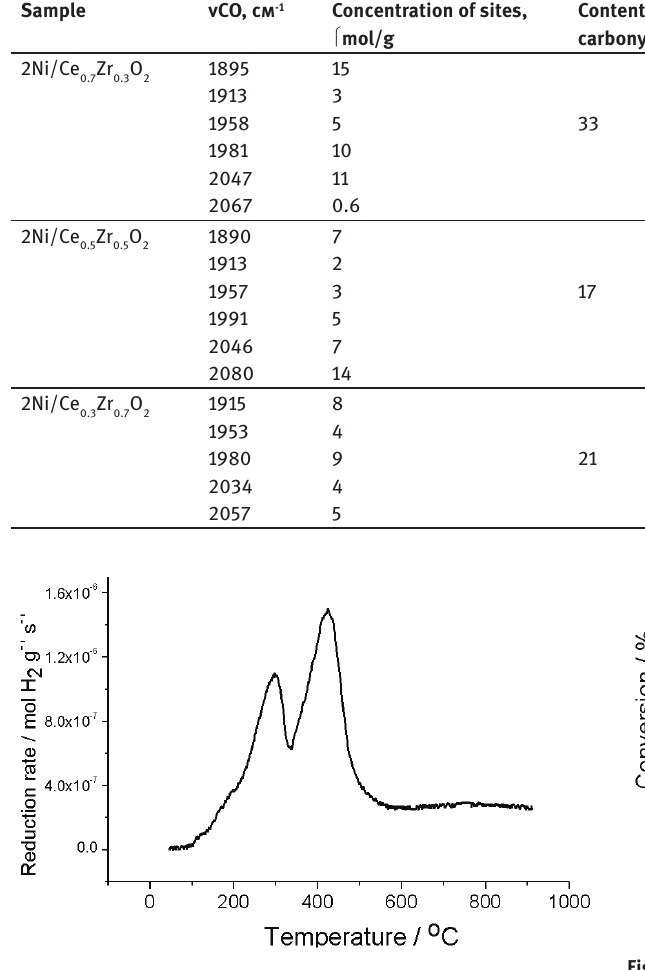
Zr O catalyst in feed 5% CH 0.5 0.5 2 in He. 2